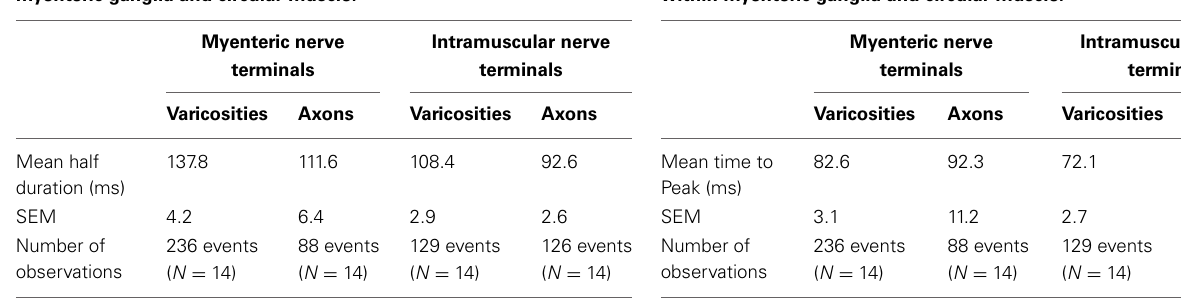
a calcium transient at the same time as the activation of the varicosities. The relative changes in fluorescence were reported as delta F / F o , where delta F stands for the change in fluorescence intensity and F o for the baseline level.